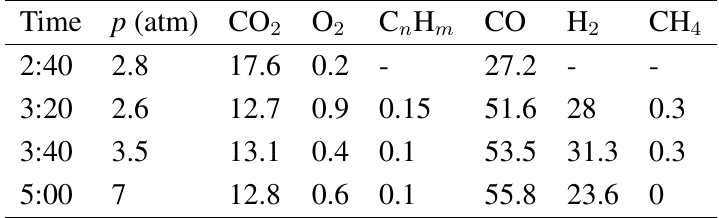
Table 1. Gas data from the first stream experiment in